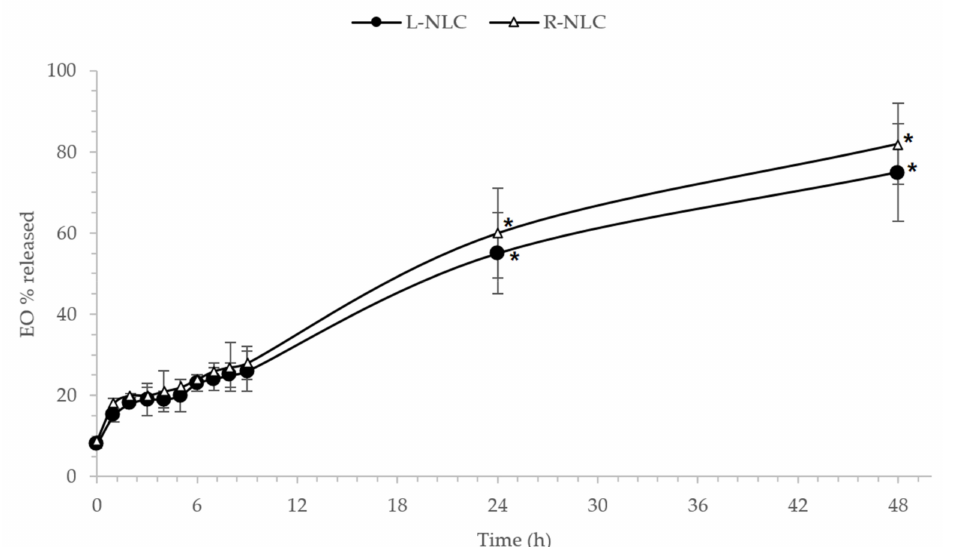
Figure 7. Percentage of Lavandula and Rosmarinus EOs released from L-NLC and R-NLC, respec- tively, at different time intervals up to 48 h. Each value is the mean of six independent experiments. * Significance for p <